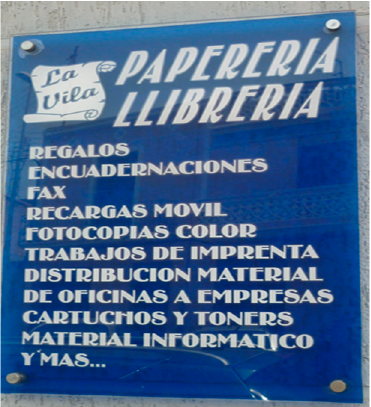
Figure 31. Almazora: Bilingual sign on a stationery shop .